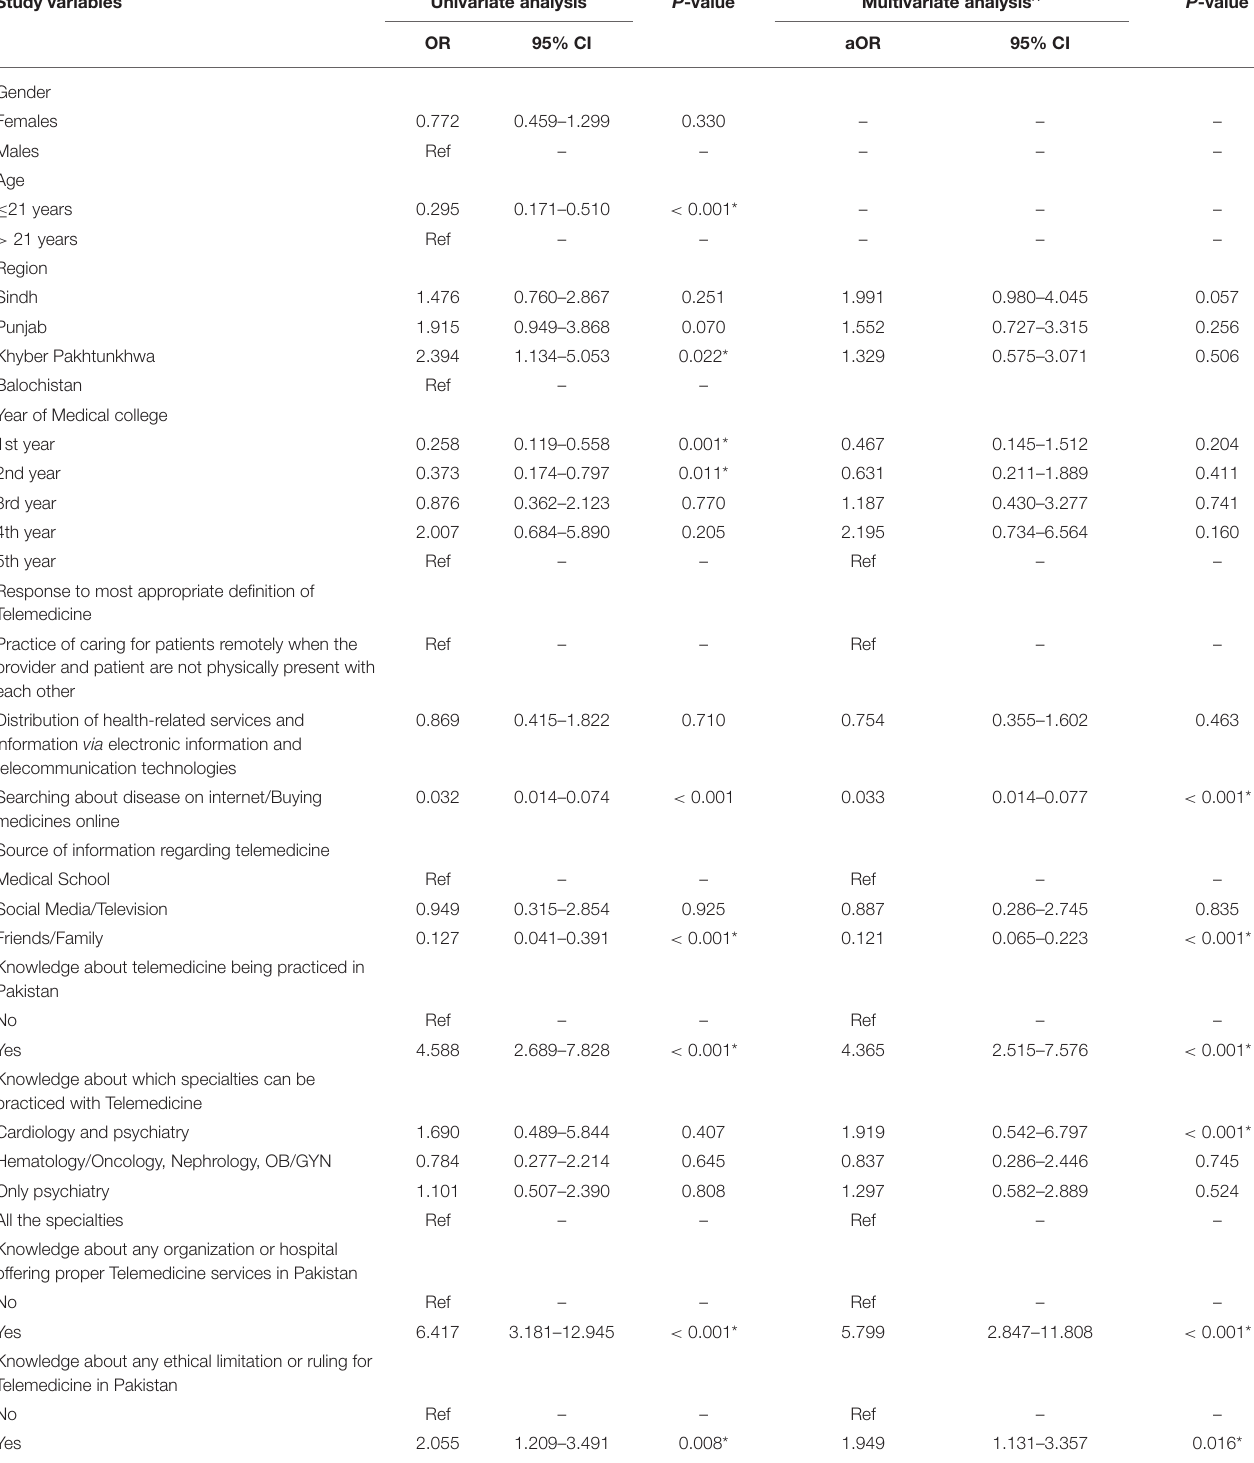
TABLE 3 | Regression analysis of characteristics associated with telemedicine knowledge ( n =